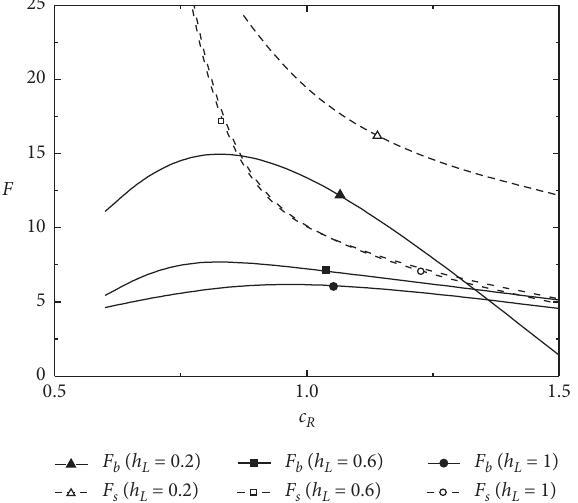
Figure 15: Effect of asymmetry ( h and snap through load ( F s ) of a portal frame with c L /h L � c R /h R and e �